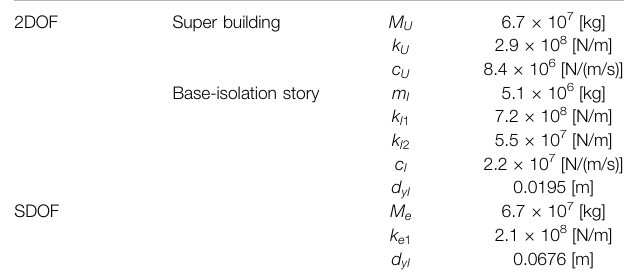
TABLE2| Parametersof2DOFmodelandSDOFmodelofbase-isolatedbuilding. 2DOF